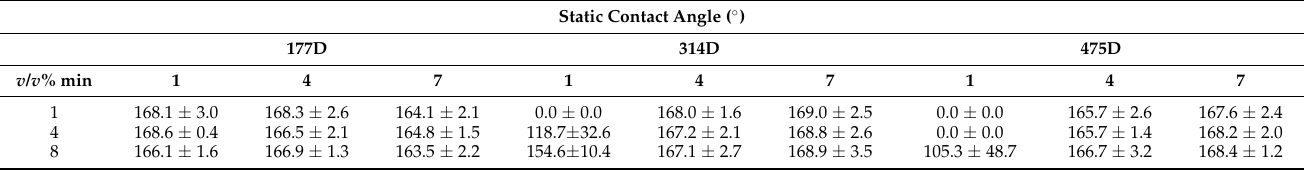
Table 3. Static contact angles of 177D, 314D, and 475D according to PDMS concentrations (1, 4, and 8 v / v %) and coating durations (1, 4, and 7 min).